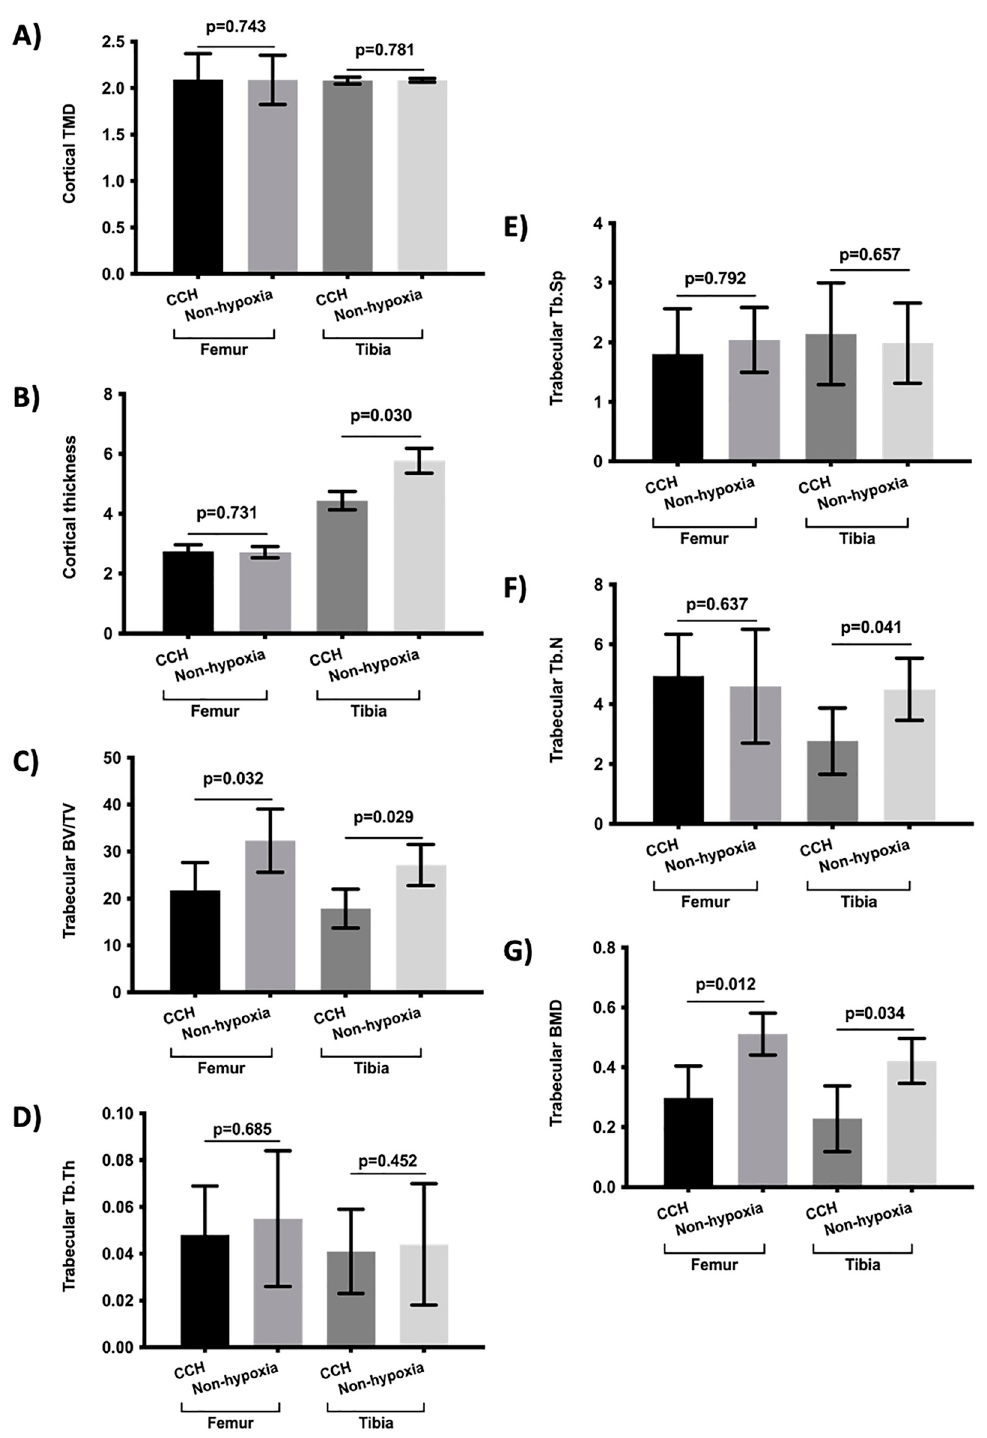
Figure 1. Comparison of bone morphometry parameters between rats subject to chronic constant hypoxic (CCH) condition and controls (non-hypoxia). ( A ) Cortical TMD, ( B ) cortical thickness, ( C ) trabecular BV/TV, ( D ) Tb.Th, ( E ) Tb.Sp, ( F ) Tb.N, and ( G ) trabecular BMD. Variables are presented as mean (standard deviation). TMD: tissue mineral density, BV/TV: percent bone volume; Tb.Th: trabecular thickness; Tb.Sp: trabecular separation; Tb.N: trabecular number; and BMD: bone mineral density.